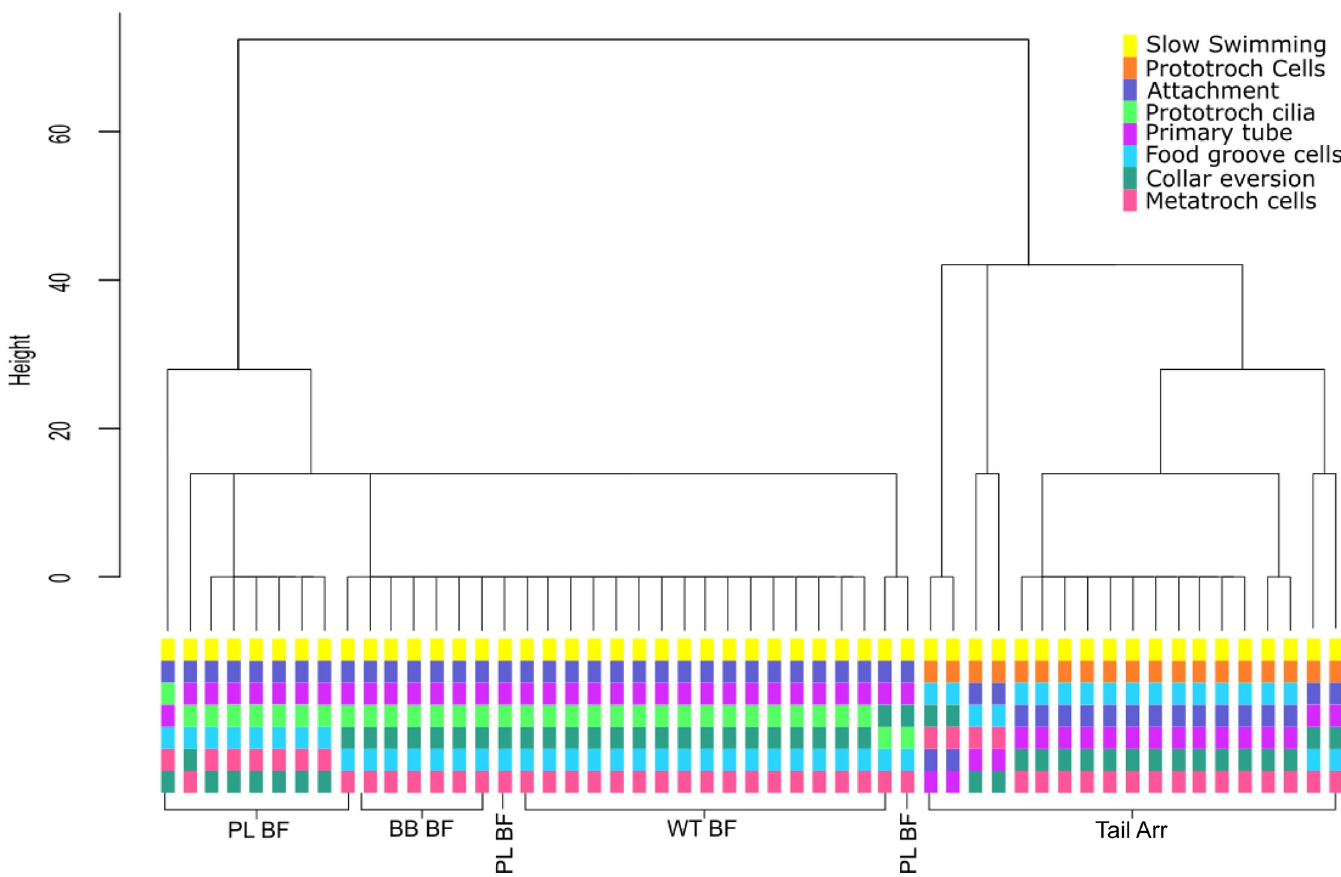
Fig 2. Dendrogram of hierarchical cluster analysis using optimal matching generated with the TraMineR package [13]. The height of the vertical lines reflects the level of separation. Below the dendrogram, the sequence of events for each sample is included. Samples are labelled according to the settlement inducing treatment they received: Tail Arr, semi-purified preparation of tailocin arrays and cellular products from P . luteoviolacea ; PL BF, biofilm of P . luteoviolacea ; BB BF, natural biofilms accumulated in the absence of light; WT BF, natural biofilms accumulated in the presence of light.